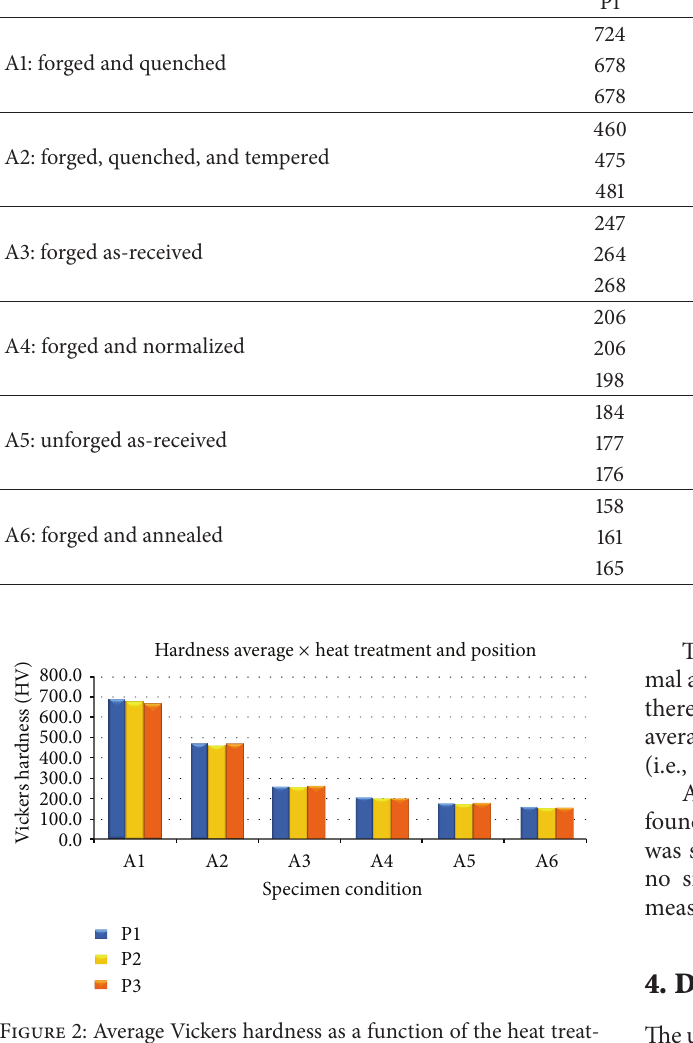
Figure 2: Average Vickers hardness as a function of the heat treat- ment and measurement